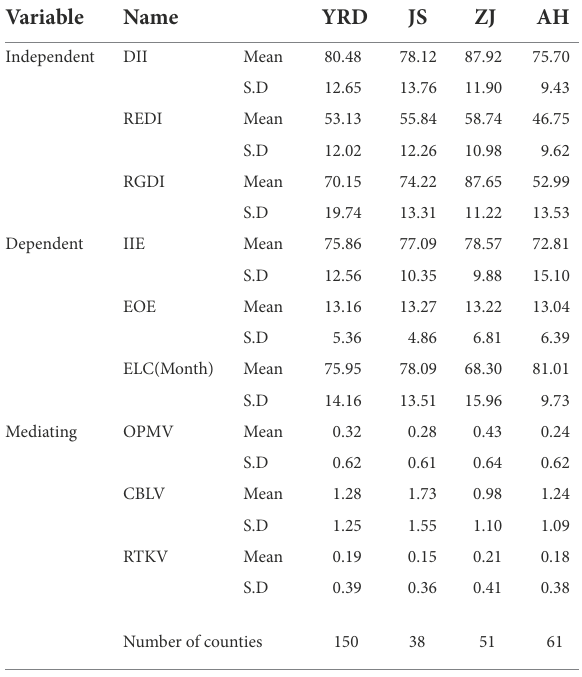
TABLE 3 Statistical values of independent, dependent, and mediating variables (proxy variables) at the YRD level and at the provincial